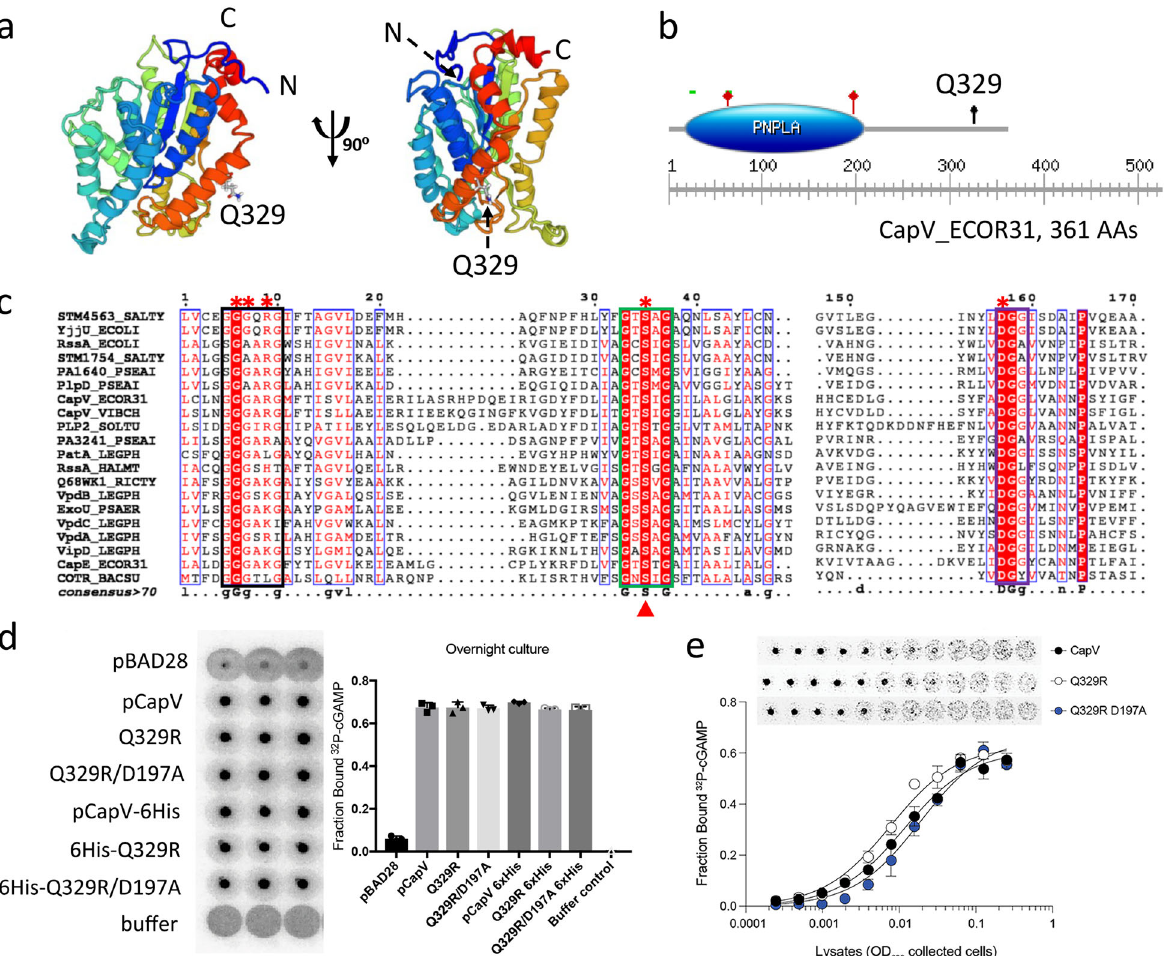
Fig. 3 Bioinformatic analysis of the patatin-like phospholipase CapV of E. coli ECOR31 and capacity to bind cyclic AMP-GMP. a Predicted structural model of the CapV from E. coli ECOR31 shown as ribbon representation. The structural model was built with the I-TASSER server, the result was processed with SWISS-MODEL. The model was based on the coordinates of the 22% identical protein FabD from Solanum cardiophyllum (PDB: 1oxwC). b The graphical representation and schematic indication of the positions of the conserved motifs (indicated by the green bar) and putative active site residues S64 and D197 (marked by red stars) in the PNPLA domain of the 361 aa CapV from E. coli ECOR31 (from L19 to F210). Black arrow, Q329. The graph was assessed by ExPASy_Prosite. c Sequence alignment of CapV from E. coli ECOR31 and selected known phospholipases from other species establishes the conserved motifs of the PNPLA domain, G – G-G-x-[K/R]-G, G-x-S-x-G, and D – G-[A/G], boxed in black, green, and purple, respectively. Entirely conserved residues are shown in white on a red background. Conserved residues are boxed. Putative catalytic residues of CapV are indicated with fi lled red triangles. The residues in CapV Q329R mutated to alanine are marked with red asterisks above the sequence. The consensus sequence at the bottom indicates in uppercase letter residues with 100% identity and in lowercase letter residues with higher than 70% conservation. Alignment was performed using CLUSTALW, and the result was processed with ESPript 3.0. Sequence identity as in the Methods section. d 32 P-cAMP-GMP-DRaCALA of E. coli cell lysates expressing CapV, CapV Q329R , and CapV Q329R/D197A . VC = pBAD28; pCapV = CapV cloned in pBAD28; Q329R = CapV Q329R cloned in pBAD28. D197A = CapV Q329R/D197A cloned in pBAD28. e Assessment of af fi nity for cAMP-GMP of CapV, CapV Q329R , and CapV Q329R/D197A expressed in E. coli